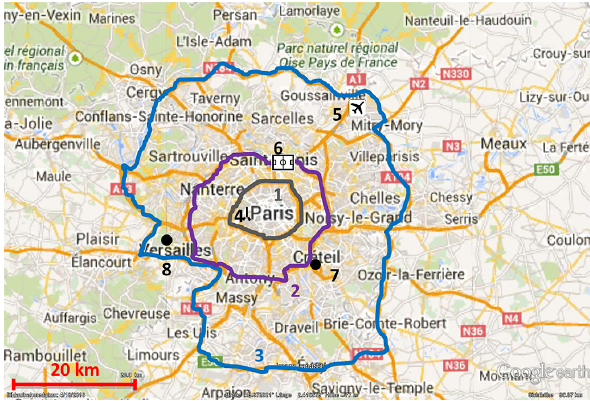
Figure 1. Typical driving routes around Paris with different radii. The numbers indicate the following – 1: small circle